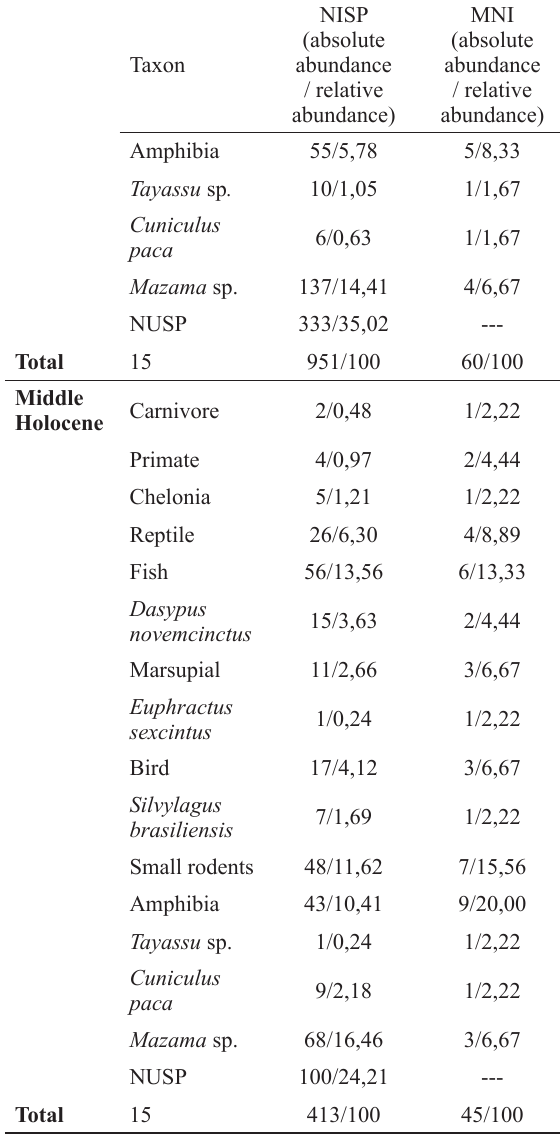
Bone Industry in the Early and Middle